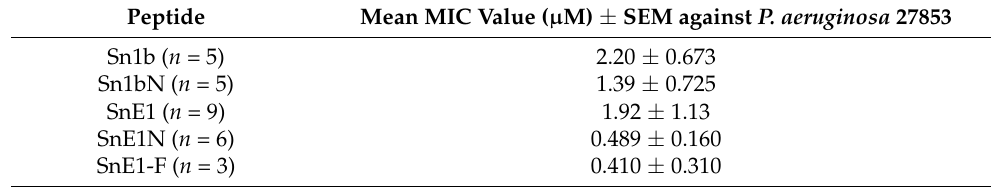
Table 4. MIC values of parent and next generation peptides. MIC values of next generation and parent peptides when tested against P. aeruginosa 27853 using RDAs.